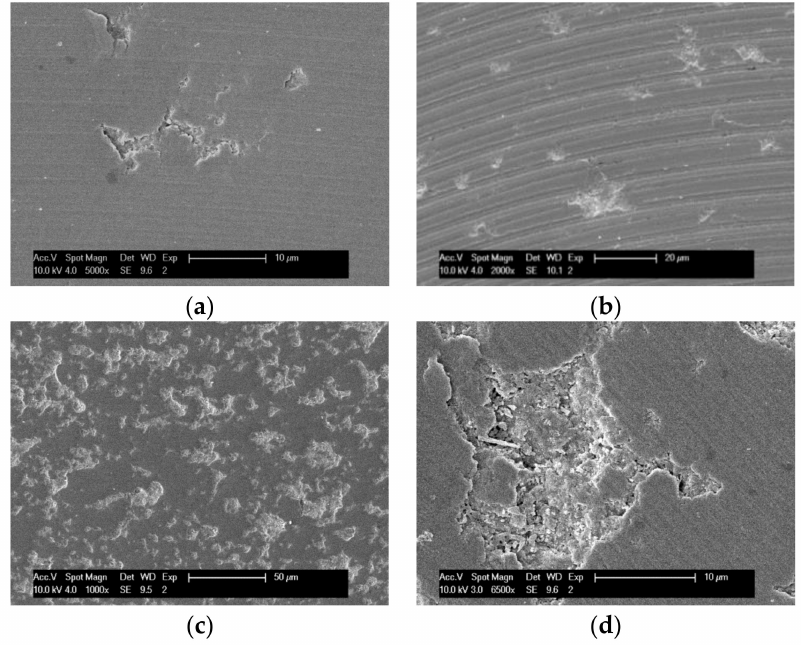
Figure 15. Typical machined surfaces with brittle damage: ( a ) tiny flaws; ( b ) scattered micro-pits; ( c ) large areas of brittle failure; ( d ) specific damage area.